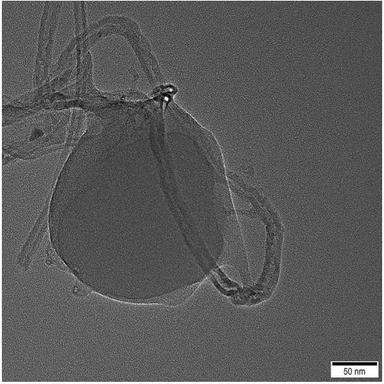
TEM of C-PCMs.